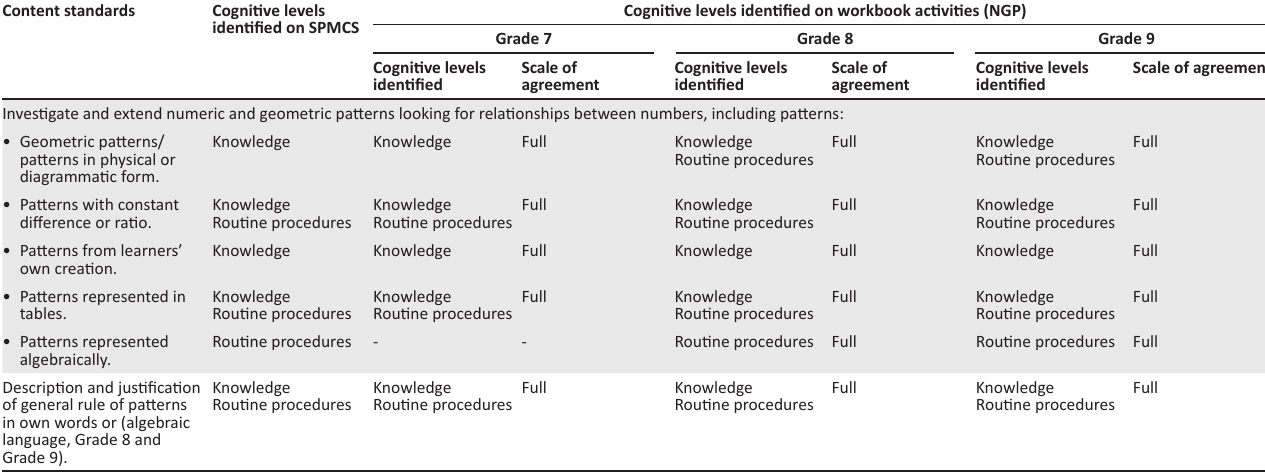
TABLE 2. Grades 7–9 depth of knowledge consistency and scale of agreement. Content